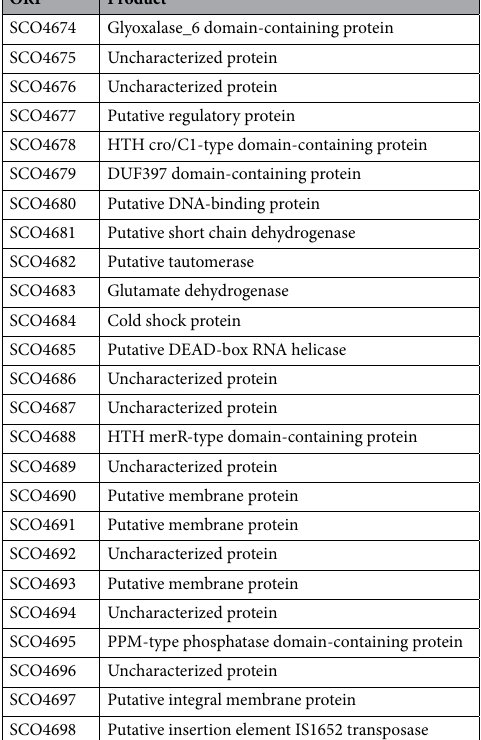
Table 1. List of the ORFs mapping in the overrepresented region of S. coelicolor chromosome. Products were inferred from